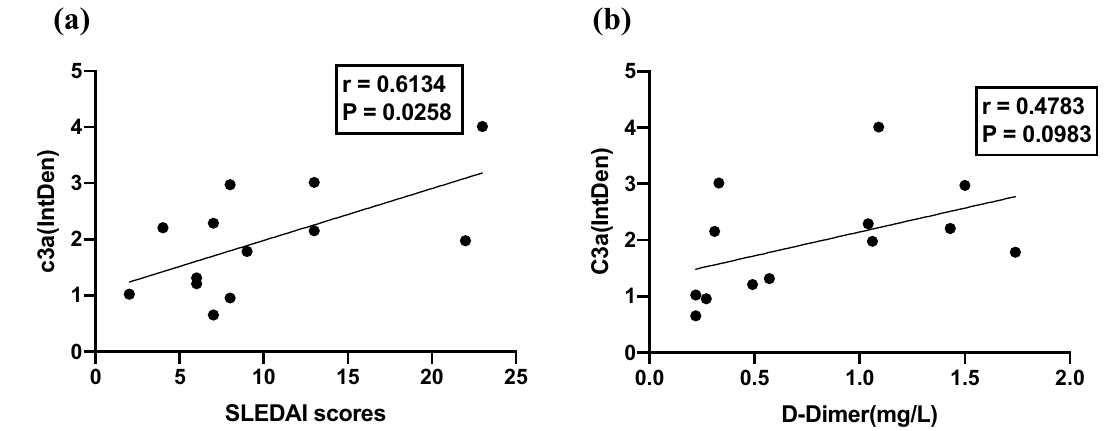
Figure 2. Correlations between serum C3a, SLEDAI scores, and D-dimer levels. ( a ) Serum C3a levels were significantly positively correlated with SLEDAI scores. ( b ) Serum C3a levels exhibited a trend towards correlation with D-dimer levels in SLE patients. P < 0.05 was the threshold of significance. SLEDAI: Systemic Lupus Erythematosus Disease Activity